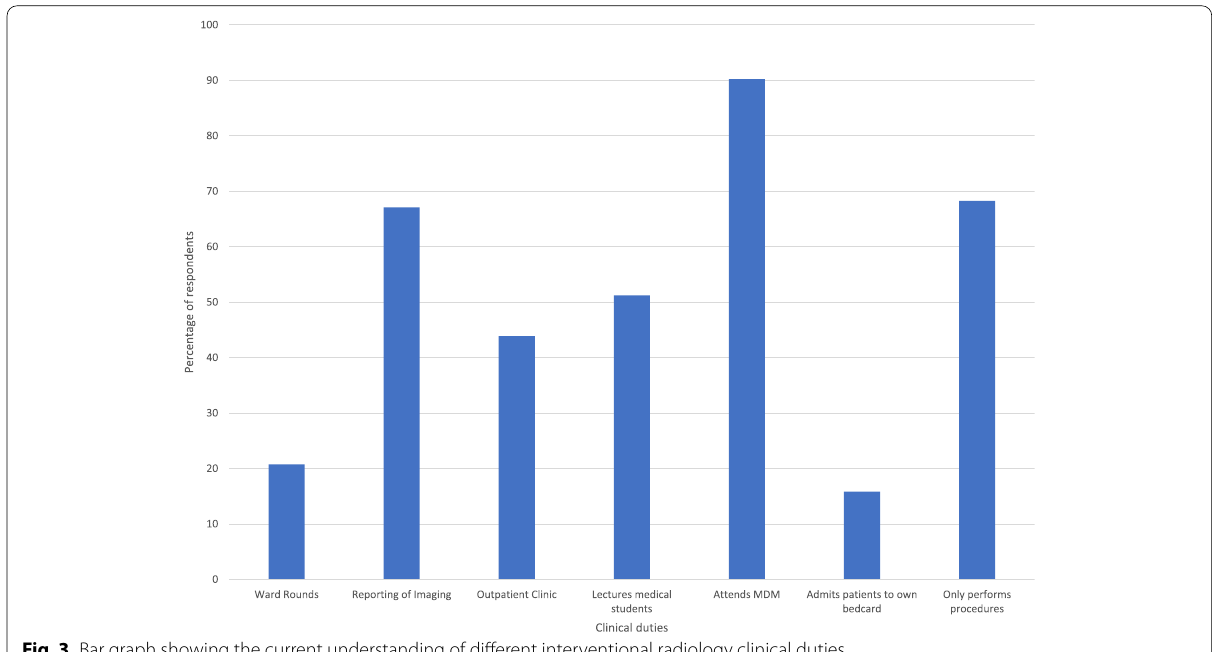
Fig. 3 Bar graph showing the current understanding of different interventional radiology clinical duties